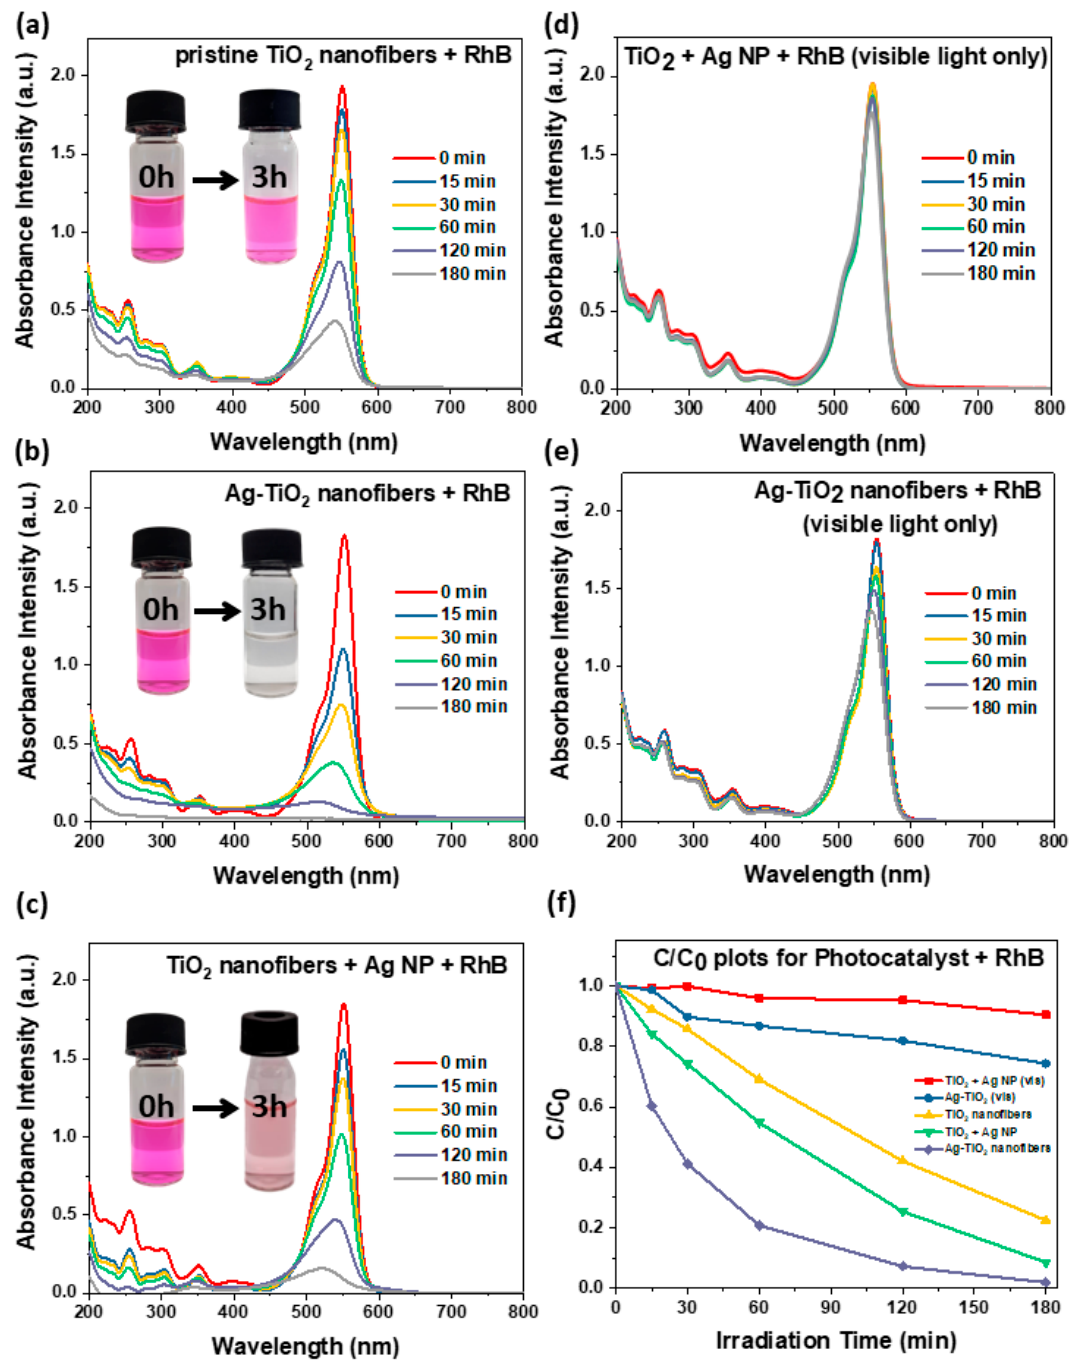
Figure 4. Photodegradation study of rhodamine B (RhB) dye with varying photocatalyst and solar irradiation conditions. For visible-light-only irradiation, a filter was applied to the AM 1.5G solar simulator such that λ incident > 390 nm. ( a ) Use of pristine TiO 2 nanofibers under solar irradiance; ( b ) Ag-TiO 2 nanofibers under solar irradiance; ( c ) TiO 2 nanofibers with extraneously added Ag nanoparticles (NPs) under solar irradiance; ( d ) TiO 2 nanofibers with extraneously added Ag NPs under visible-light-only irradiance; ( e ) Ag-TiO 2 nanofibers under visible-light-only irradiance; and ( f ) C/C 0 plots for the various dye degradation setups with RhB in the following order: TiO 2 + Ag NPs under visible-only light (red), Ag-TiO 2 under visible-only light (blue), pristine TiO 2 nanofibers under full solar irradiation (yellow), TiO 2 + Ag NPs under full solar irradiation (green), Ag-TiO 2 nanofibers under full solar irradiation